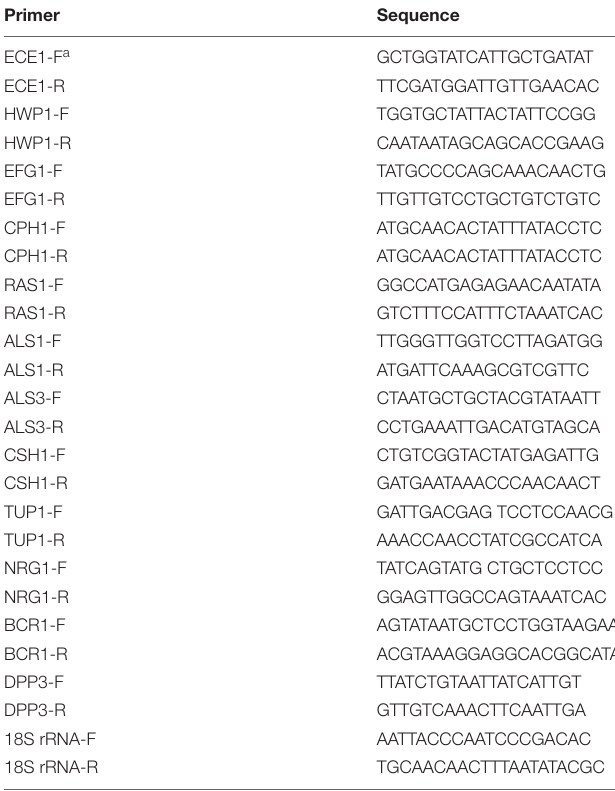
TABLE 1 | Primers used in this